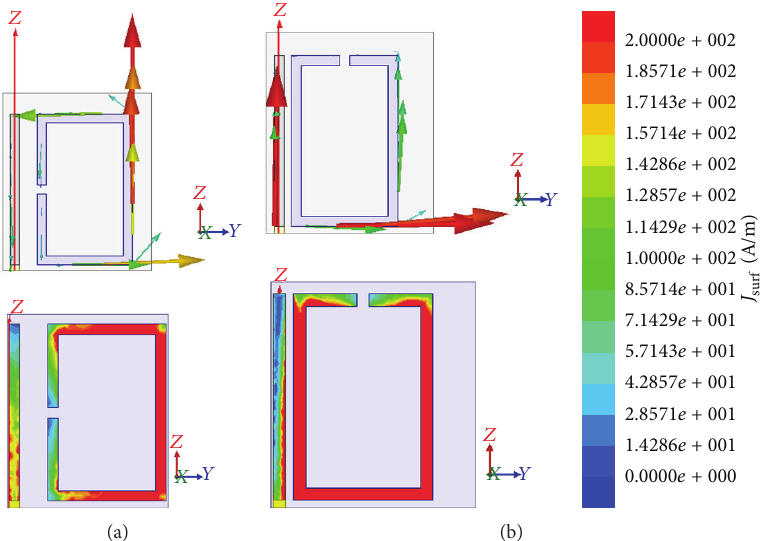
Figure 7: Simulated vector (up) and scalar (down) currents on the monopole and the SRR at the operating frequency 𝐹 𝑅 and for the coupling distance 𝑑 1 : (a) configuration A1 ( 𝐹 𝑅 = 1.55 GHz, 𝑑 1 = 4 mm); (b) configuration A2 ( 𝐹 𝑅 = 1.75 GHz, 𝑑 1 = 1